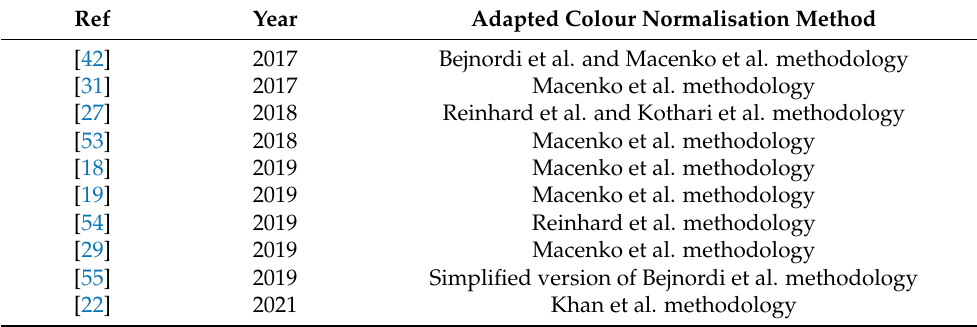
Table 2. Comparison of adopted colour normalisation